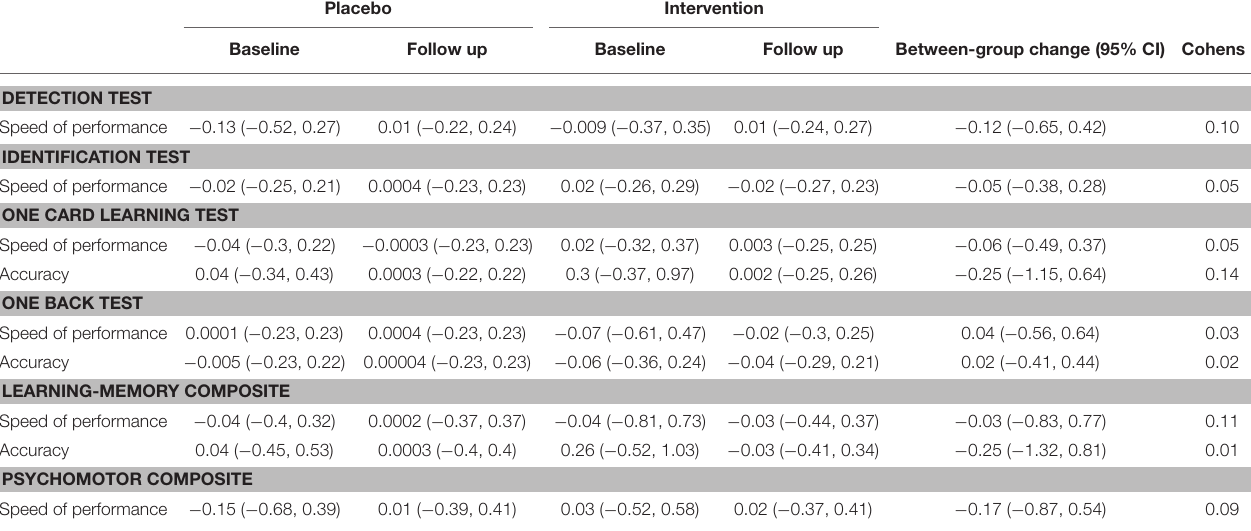
TABLE 2 | Mean ( ± 95% confidence intervals) in cognitive outcomes (standardized Z scores) from baseline to end of treatment. Placebo Intervention Baseline Follow up Baseline Follow up Between-group change (95% CI) Cohens D DETECTION TEST Speed of performance − 0.13 ( − 0.52,